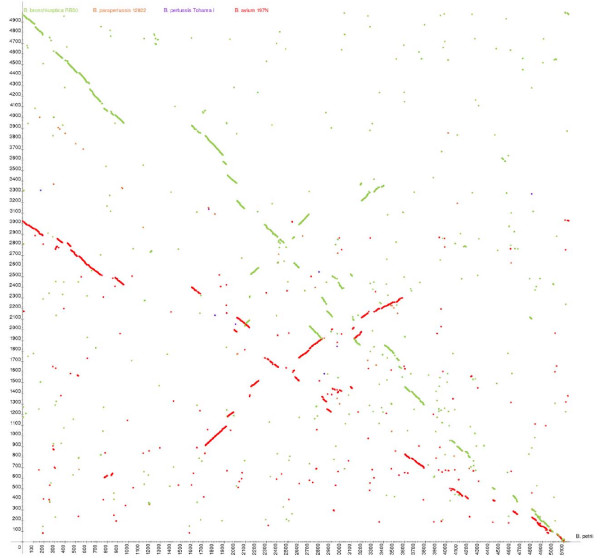
B. petrii syntenic plot. Syntenic plot between the genomes of B. petrii strain DSMZ12804, B. bronchiseptica RB50, B. parapertussis 12822, B. pertussis Tohama I and B. avium 197N. The diagram depicts x-y plots of dots forming syntenic regions between B. petrii (x-axis) and the three other Bordetella genomes (y-axis), with coordinates corresponding to the CDS number in each genome. Each coloured dot (green, B. bronchiseptica RB50; orange, B. parapertussis 12822; lilac, B. pertussis Tohama I; red, B. avium 197N) represents a B. petrii strain DSMZ12804 CDS having an orthologue in one of the three compared genomes. The orthologues were identified by bi-directional best BLASTP matches of amino acid sequences (e-value < e-30).